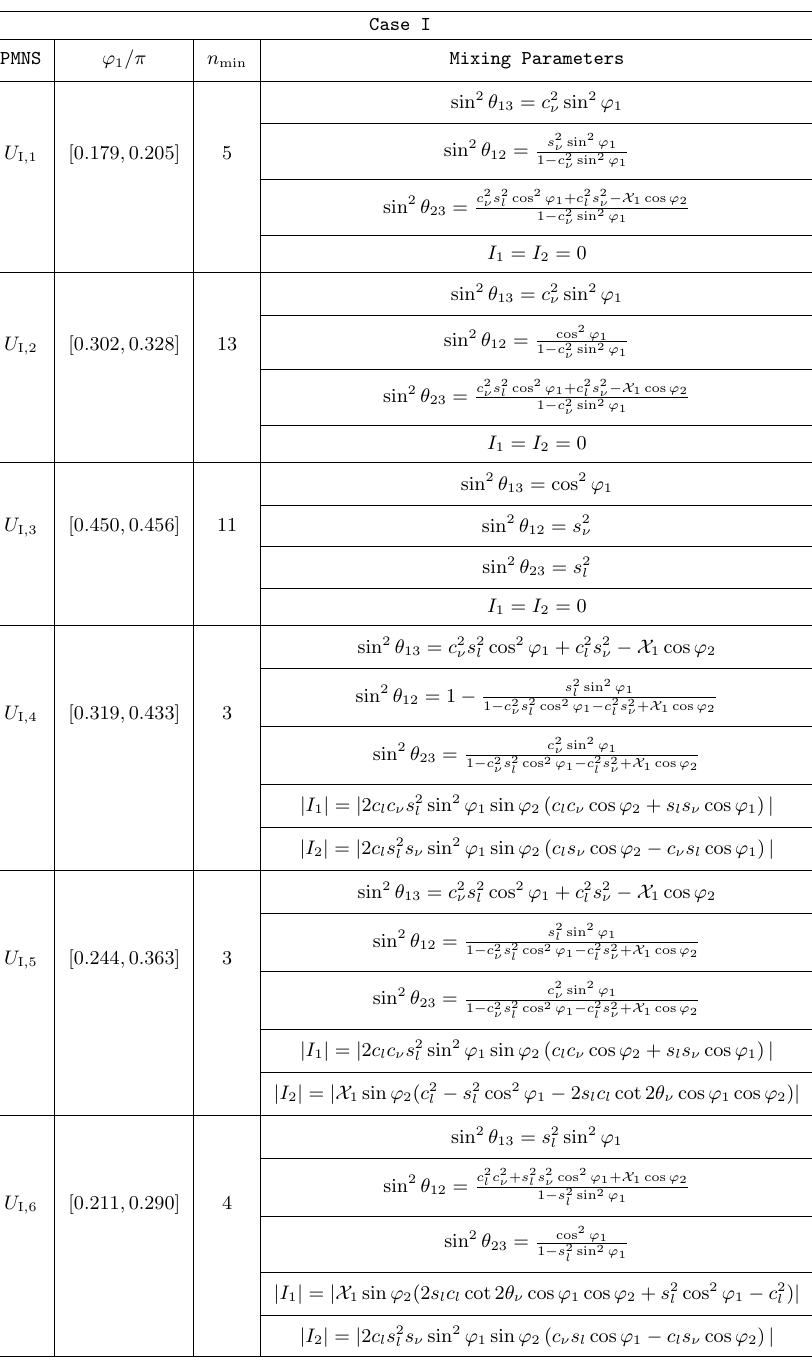
Table 3 . The predictions of the mixing parameters for all the nine permutations of the mixing matrix in the case I. The magnitude of J CP is identical for all the nine mixing patterns, i.e. j J CP j = admissible range of ’ 1 in the second column is obtained from the requirement that the (cid:12)xed element cos ’ 1 is in the experimentally preferred 3 (cid:27) range. The notation n min denotes the smallest value of the group index n which can give a good (cid:12)t to the experimental data [8]. Here the neutrino mass spectrum is assumed to be NH, and the range of ’ 1 would change a little for IH.